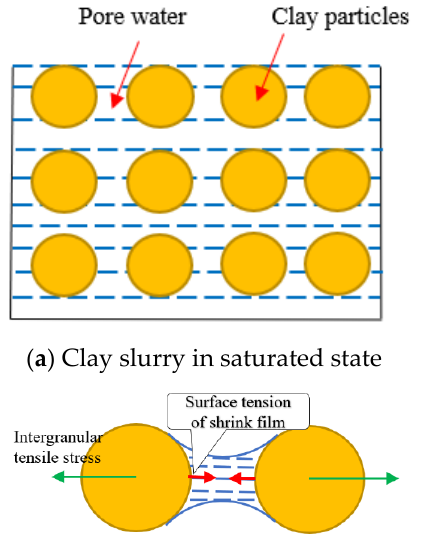
Figure 5. Clay cement slurry consolidation process.